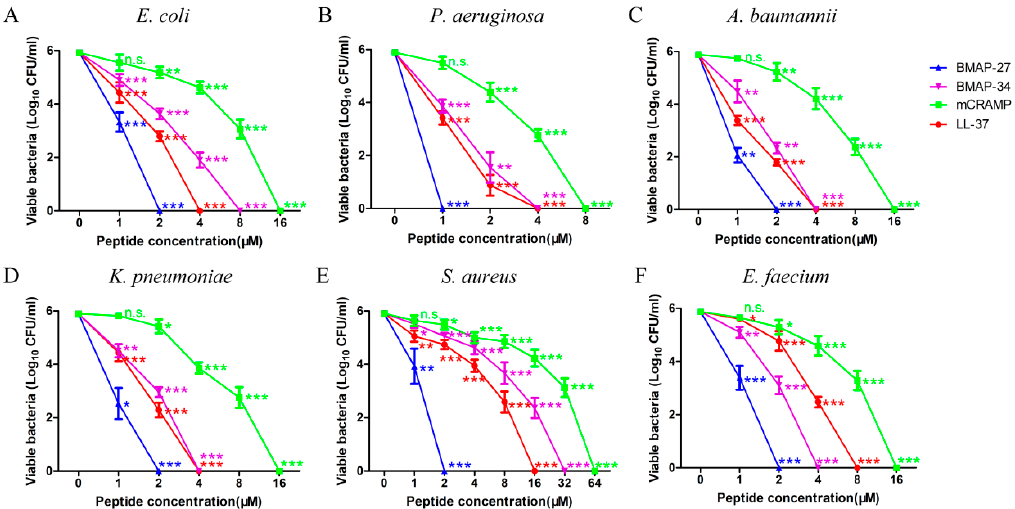
Figure 2. Mammalian cathelicidins effectively kill both Gram-negative and Gram-positive bacteria. Bactericidal activities of BMAP-27, BMAP-34, mCRAMP, and LL-37 on ( A ) E. coli ATCC 25922, ( B ) P. aeruginosa ATCC 27853, ( C ) A. baumannii ATCC 19606, ( D ) K. pneumoniae ATCC 700603, ( E ) S. aureus ATCC 29213, and ( F ) E. faecium ATCC 700221. Each strain was incubated with different peptides at varying concentrations for 2 h, and the number of bacterial colonies was calculated. Values represent the mean ± SD from three independent assays, * p < 0.05, ** p < 0.01, *** p < 0.001, n.s. = not significant.